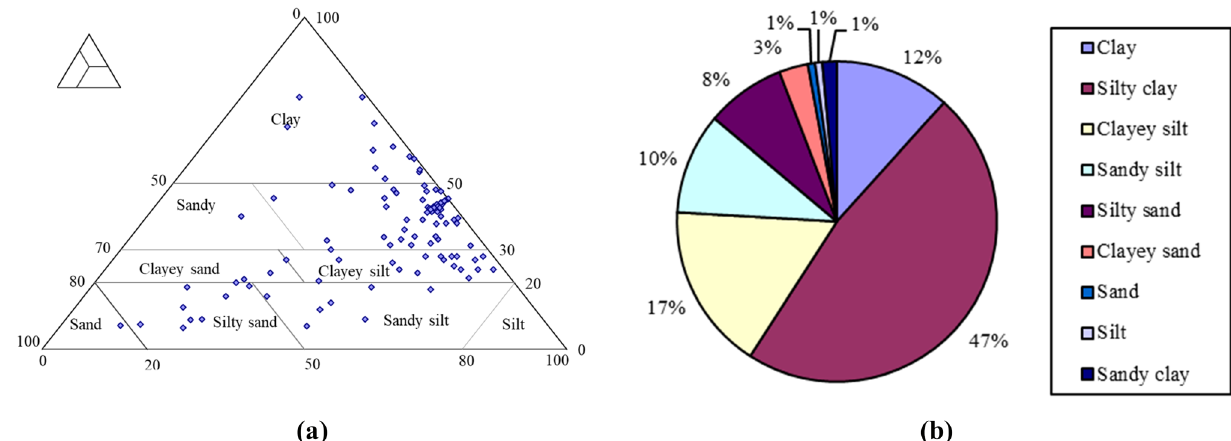
Fig. 1 Grain size distribution for Prazeres Clay: a Feret’s triangle; b percentual distribution